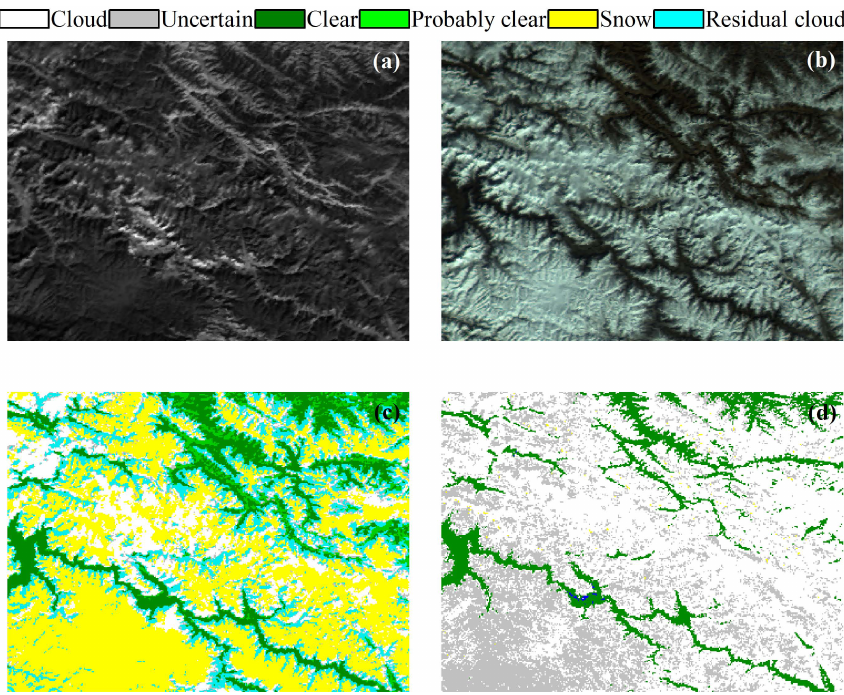
Fig. 7. The case over snow-covered region on 22 January 2011 at 05:35:00UTC. (a) The gray-scale image of VIRR channel 6 (1.55– 1.64µm); (b) the true-color VIRR image composed of channel 1 (red), channel 9 (green), and channel 7 (blue); (c) the cloud mask result from the algorithm proposed in this study; (d) the official cloud mask product image from